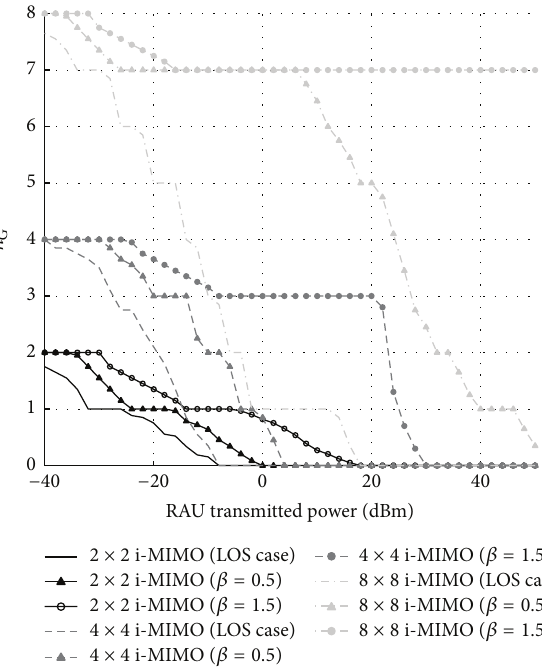
Figure 7: Comparison of 2-, 4-, and 8-branch i-MIMO DAS performance in the linear deployment (corridor) case. Average number of branches under threshold ( 𝑛 𝐺 ) is shown for different values of the propagation model parameters (RAU antenna distance: 20 m).